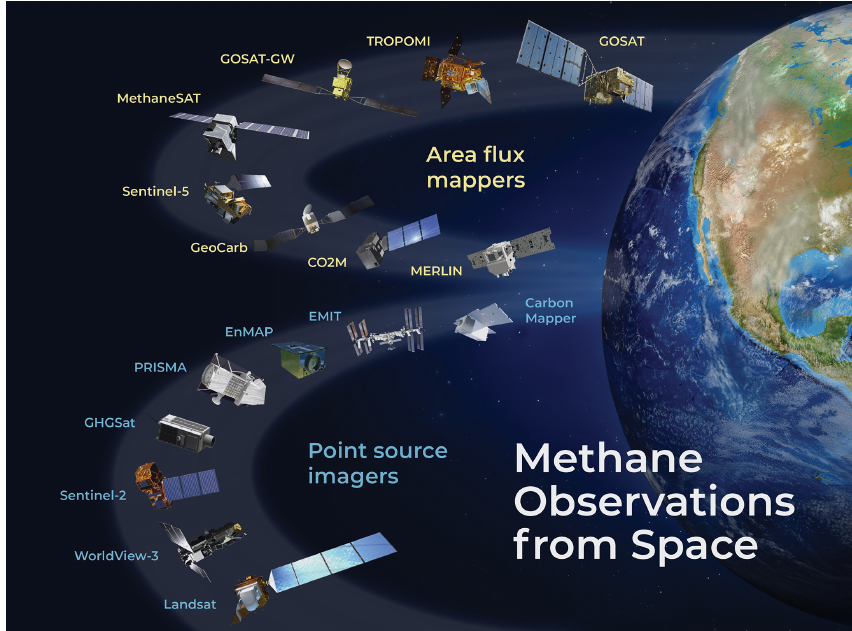
Figure 1. Satellite instruments for observation of methane in the shortwave infrared (SWIR). Area flux mappers are designed to quantify total methane emissions on regional to global scales. Point source imagers are designed to quantify emissions from individual point sources by imaging the atmospheric plumes. Specifications for each instrument are in Tables 1 and 2. Satellite icons were obtained from https: //www.gosat.nies.go.jp (last access: 22 July 2022) for GOSAT; Wikipedia Commons for TROPOMI, EMIT (International Space Station), and Sentinel-2; https://space.skyrocket.de (last access: 22 July 2022) for GOSAT-GW, MERLIN, CO2M, and Carbon Mapper; https://www. methanesat.org (last access: 22 July 2022) for MethaneSAT; ESA (2020) for Sentinel-5; https://www.ou.edu/geocarb/mission (last access: 22 July 2022) for GeoCarb; https://www.planetek.it/ (last access: 22 July 2022) for PRISMA; https://www.ghgsat.com/ (last access: 22 July 2022) for GHGSat; https://www.enmap.org/mission (last access: 22 July 2022) for EnMAP; https://directory.eoportal.org (last access: 22 July 2022) for WorldView-3; and https://www.usgs.gov/landsat-missions (last access: 22 July 2022) for